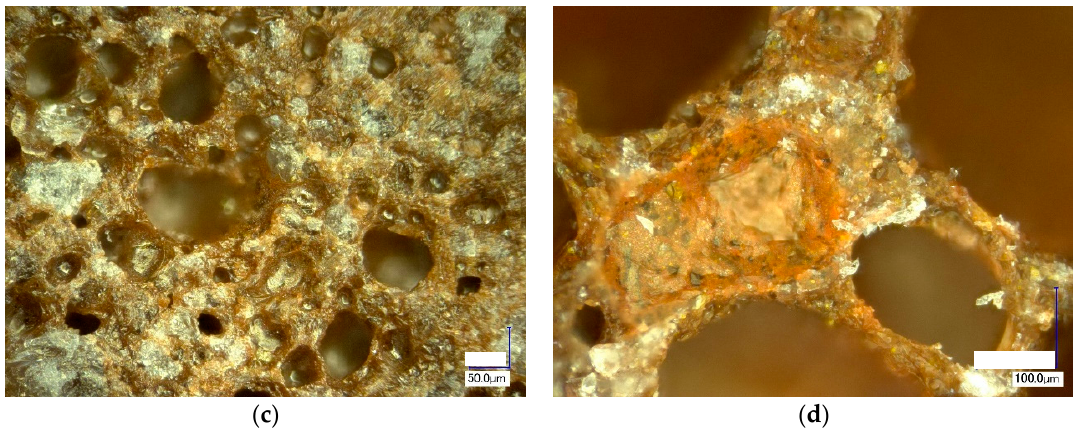
Figure 4. LM images (magnification 500×) of ceramic syntactic foam (CSF) samples ( a , b ) fired at 1000 °C with ( a ) 50 and ( b ) 60 vol % of CS addition (side view), ( c , d ) cross section of reference samples without CS addition fired ( c ) at 1150 and ( d ) 1200 °C.